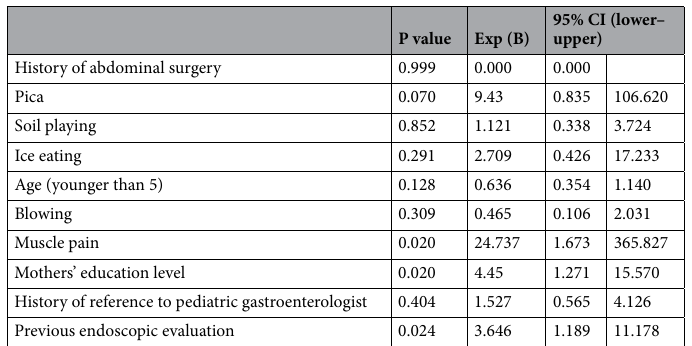
Table 4. Possible factors affecting the blood lead levels and symptoms/evaluations performed on the study groups (multivariate binomial logistic regression analysis).